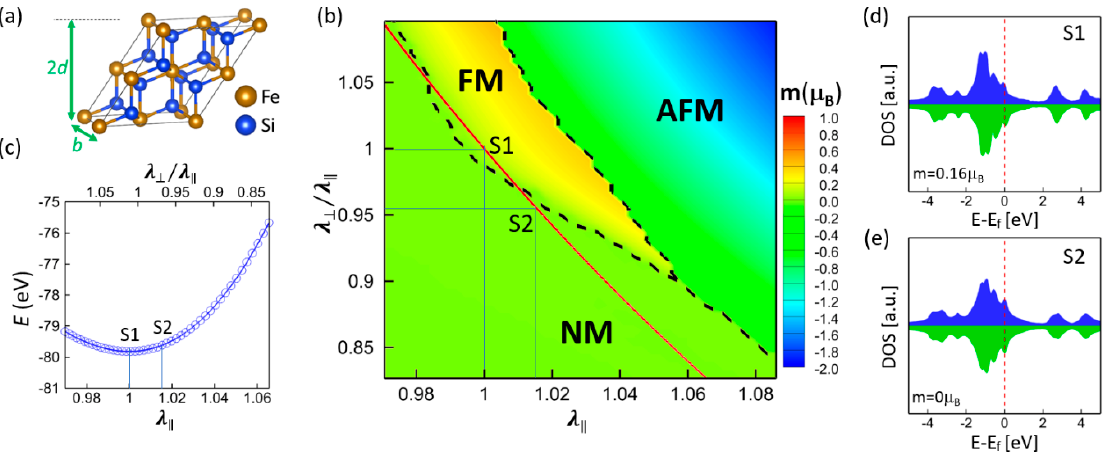
Figure 1. ( a ) γ -FeSi 2 supercell with rhombohedral deformation of (111) in-plane stretch λ (cid:107) = 2 b / a 0 and out-of-plane stretch λ ⊥ = 3 d / a 0 . ( b ) Magnetism mapping as a function of the rhombohedral deformation. The red line corresponds to the energy-minimized structure for a given λ (cid:107) and the color scale represents the calculated Fe spin moment m (positive for ferromagnetic (FM), negative for antiferromagnetic (AFM), and zero for nonmagnetic (NM)). ( c ) The calculated energy for the structures along the red line in ( b ). Magnetic moments and density of state (DOS) of Fe atoms for ( d ) S1 (unstrained state) and ( e ) S2 (epitaxially strained state).